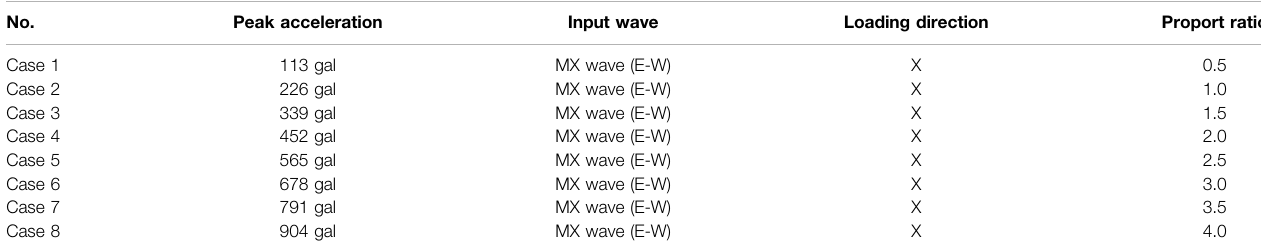
TABLE 2 | Excitation